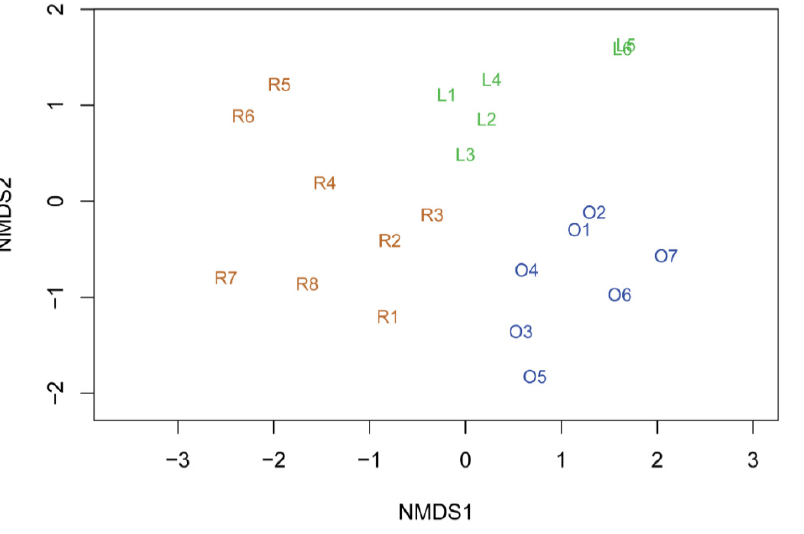
Figure 4. Non-metric multi-dimensional scaling (NMDS) plot built on ARISA profiles. Colours refer to different samples: brown = tuff rock; green = light fresco; blue = dark fresco. Temperature, light intensity and relative humidity registered at each sampling site were slightly positively correlated with the variance of biofilm community (temperature: r 2 = 0.154; light intensity: r 2 = 0.162; relative humidity: r 2 = 0.165). These correlations were all significant ( p < 0.001) and, accordingly, included in CCA analysis. All the